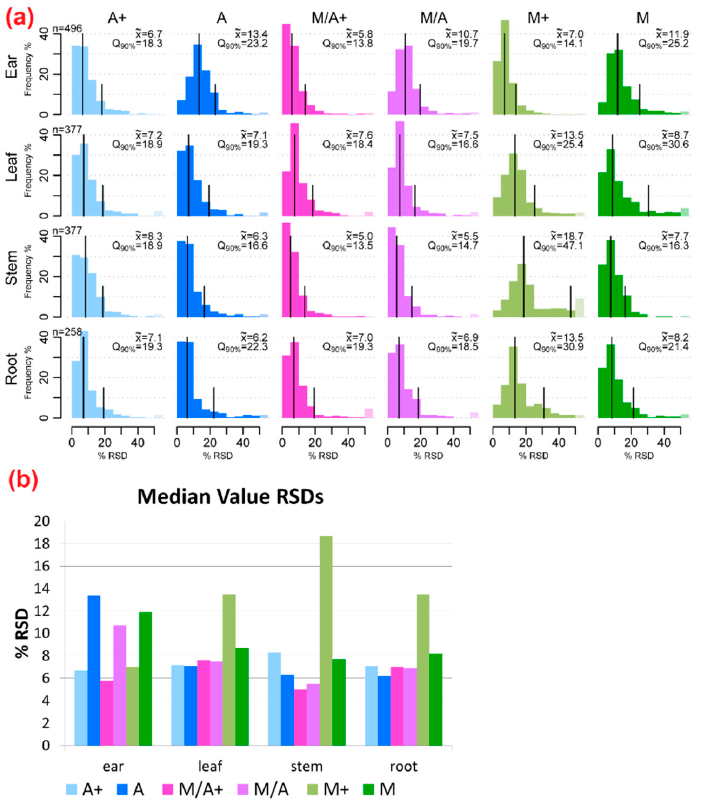
Figure 2. ( a ) Histograms of relative standard deviations (RSDs) of metabolite abundances (area of most intense 12 C EIC peak per metabolite) for all tested extraction mixture/organ combinations. RSDs were calculated for metabolites extracted with all solvents in the corresponding organ as listed in Figure 1c; ( b ) Diagram of median RSD values for the six tested extraction mixtures, sorted according to wheat organs.